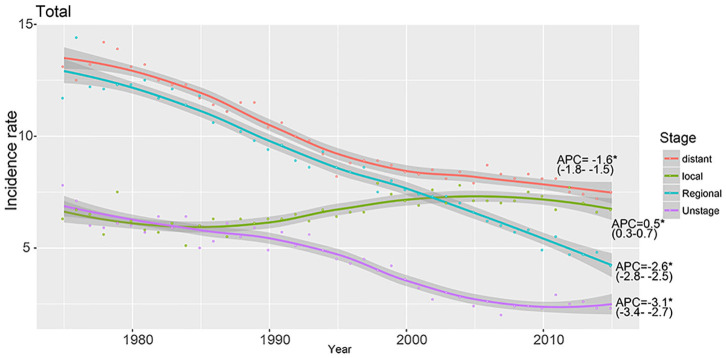
The incidence of GC at different stages is shown with APC.